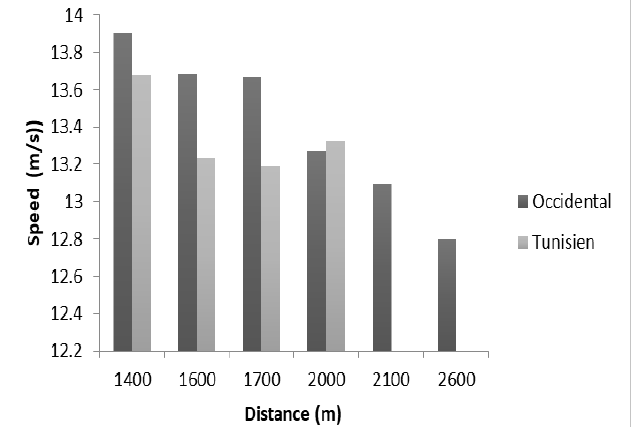
Figure 2 : Variation of the speed according to the origin of the father and the different distances